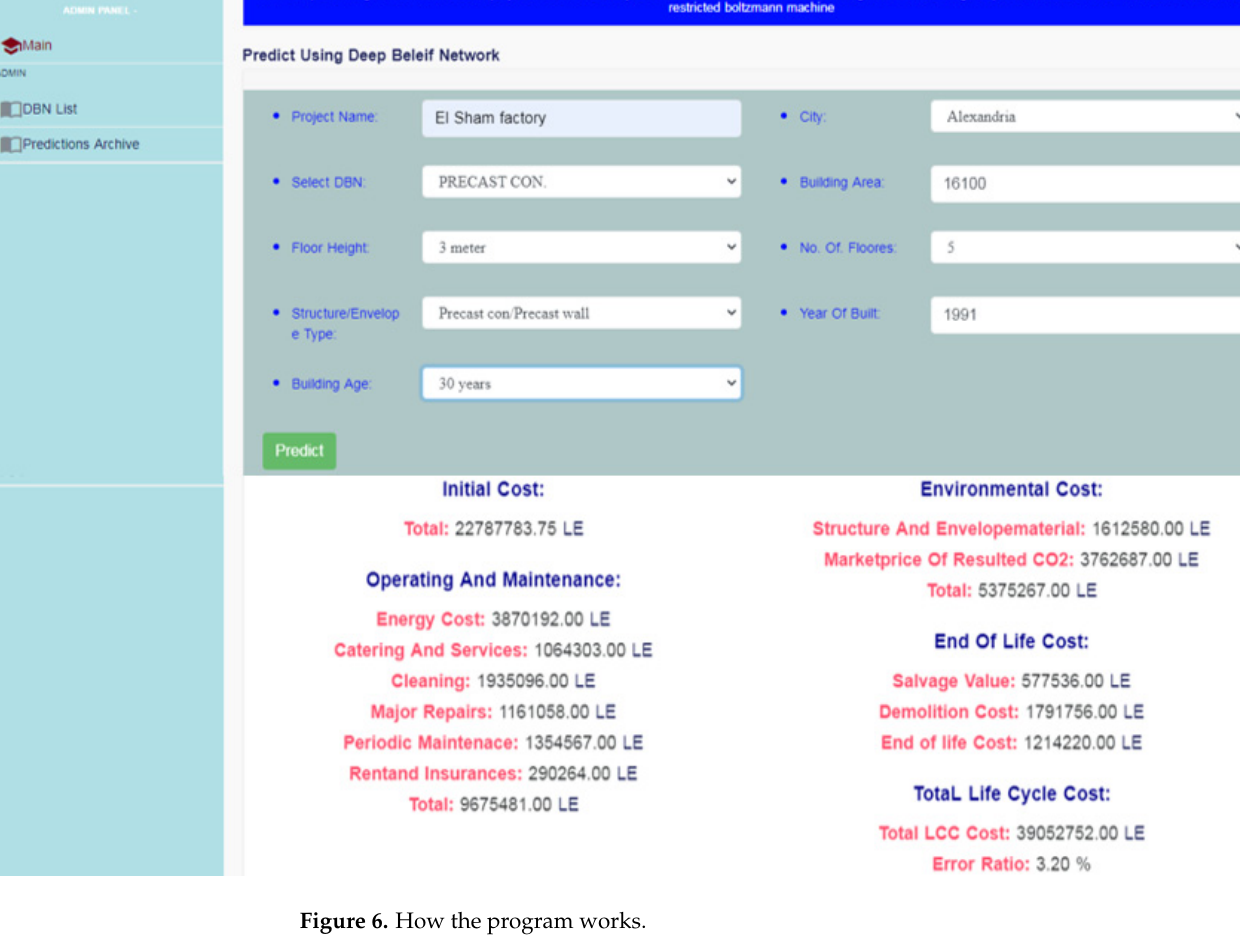
Figure 5. All required inputs of the model.